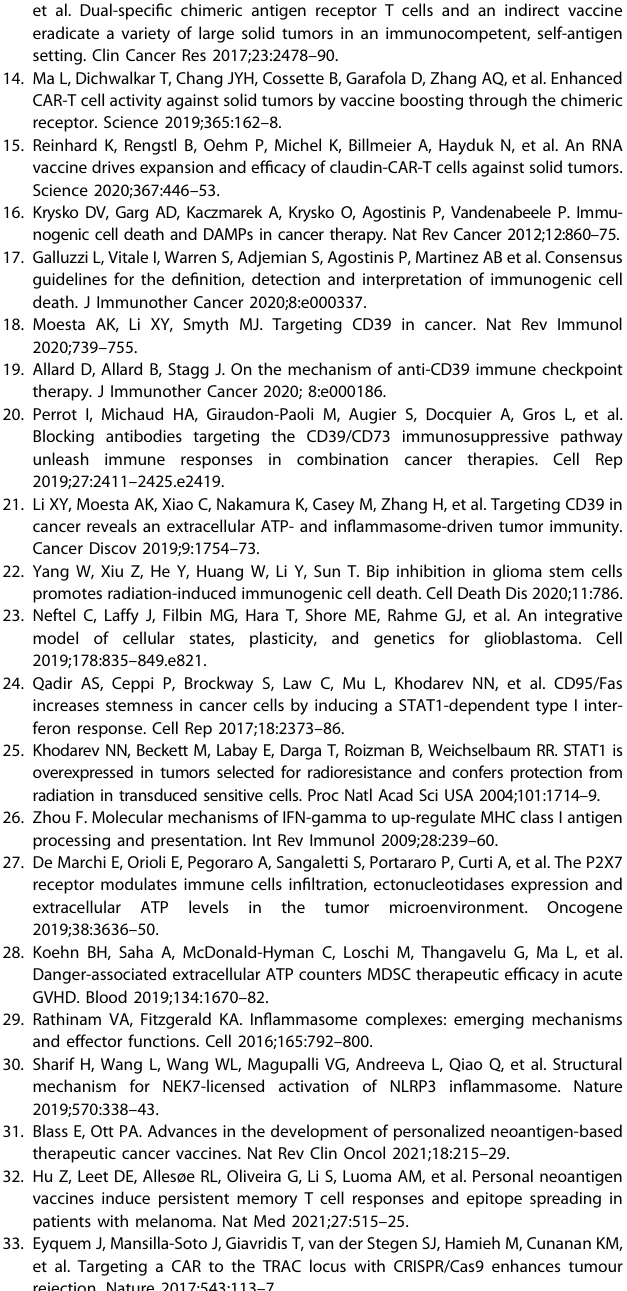
Fig. 7 ICD hallmarks in vivo activated CAR-T cells showed persistent antitumor effect. C57BL/6 J mice bearing orthotopic GL261s EGFRvIII glioma were treated with vaccine and mEGFRvIII CAR-Ts for antitumor therapy. The groups are following: 1. control group, the mice were injected with 100 μ l PBS; 2. Vaccine group, GL261s cells were pretreated with 100 μ M POM-1 for 3 hours, then irradiated with 10 Gy. The 10 7 - treated cells were inoculated s.c. into mice as a vaccine on day 19 after GL261s EGFRvIII cells implantation; 3. Control T group, the mice were administrated with 10 7 T cells from the spleen of healthy mice via tail vein on day 20 after GL261s EGFRvIII cells implantation; 4. Vaccine plus Control T group, the mice were injected with vaccine and control T cells; 5. CAR-T group, the mice were administrated with 10 7 mEGFRvIII CAR-Ts via tail vein on day 20; 6. Vaccine plus CAR-T group, the mice were injected with vaccine and CAR-Ts. A Schema of the mouse tumor model was used to test the effect of vaccine and CAR-Ts in vivo. Tumor size was measured ( B ) and the survival of mice ( C ) was analyzed. D Tumor-in fi ltrating T lymphocytes were measured using IHC stain for CD4, CD8, and FoxP3 (×400). Scale bars correspond to 20 μ m. E Tumor was removed, and tumor-in fi ltrating CAR-T cells were examined by fl ow cytometry to evaluate the intratumoral expansion. F The number